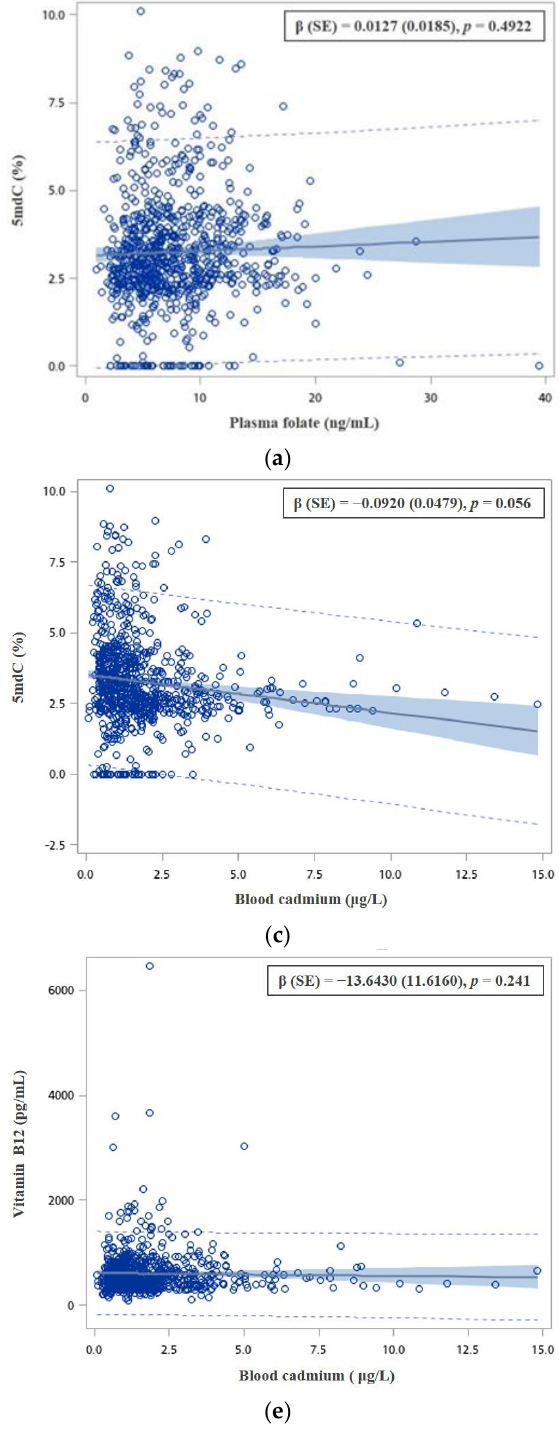
Figure 2. The association between ( a ) plasma folate level and 5mdC (%); ( b ) plasma vitamin B 12 level and 5mdC (%); ( c ) blood cadmium concentration and 5mdC (%); ( d ) blood cadmium concentration and plasma folate level; ( e ) blood cadmium concentration and plasma vitamin B 12 level. Coefficient ( β) and standard error (SE) were estimated by multivariable linear regression models, adjusted for age, sex, educational levels, BMI, cumulative cigarette smoking, alcohol, tea, and coffee consump- tion, and diagnosed history of diabetes malleus, hypertension, and chronic kidney disease.